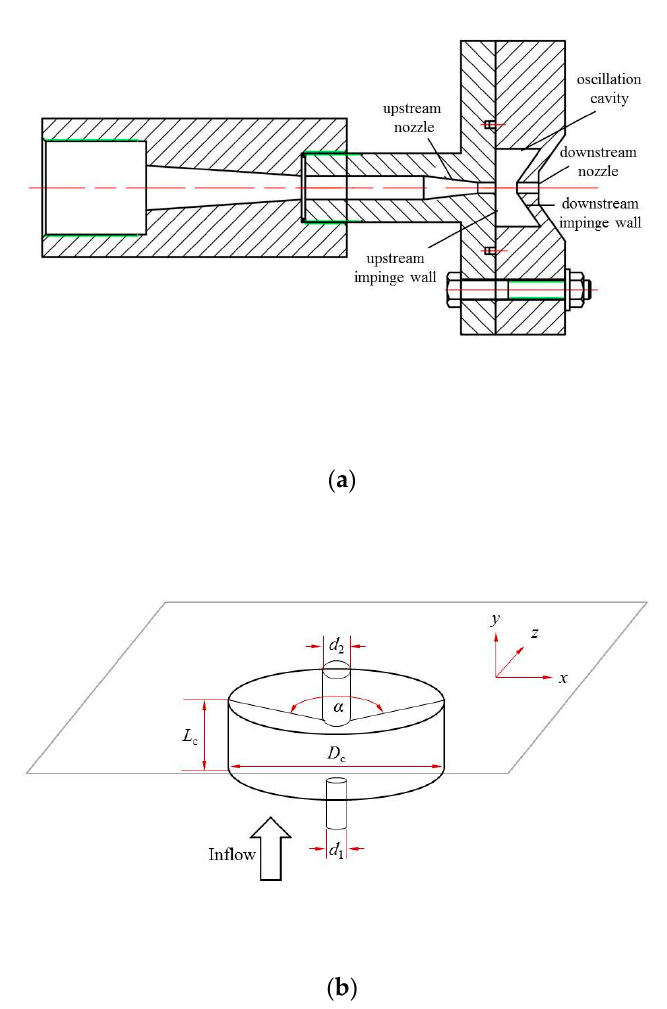
Figure 2. ( a ) Profile of a Helmholtz oscillator; ( b ) schematic view of geometry parameters.